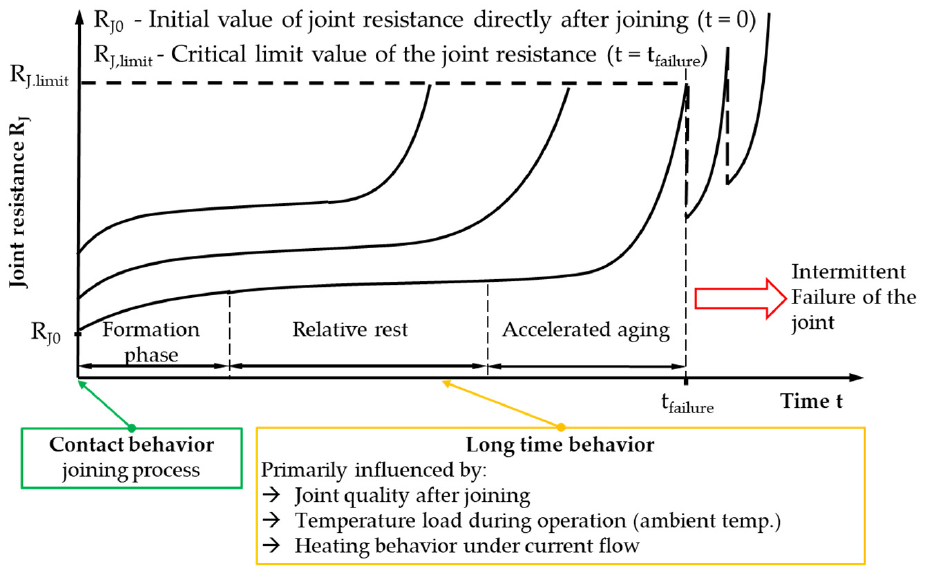
Figure 6. Lifetime characteristics of current-carrying connections according to [13].